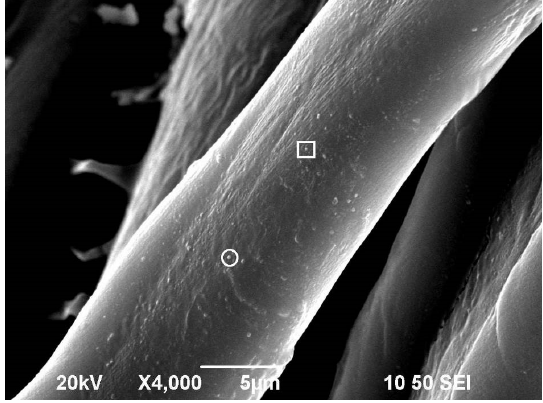
Figure 3. SEM image of plasma treated cotton fiber after pigment dyeing (with pigment agglomeration) (condition: (discharge power = 170 W; oxygen flow rate = 0.4 L/min; jet moving speed = 5 mm/s and jet to substrate distance = 3 mm).